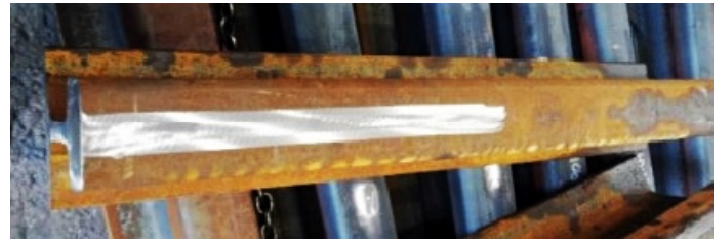
Figure 14. Rail head and foot prepared for welding. Source: own.